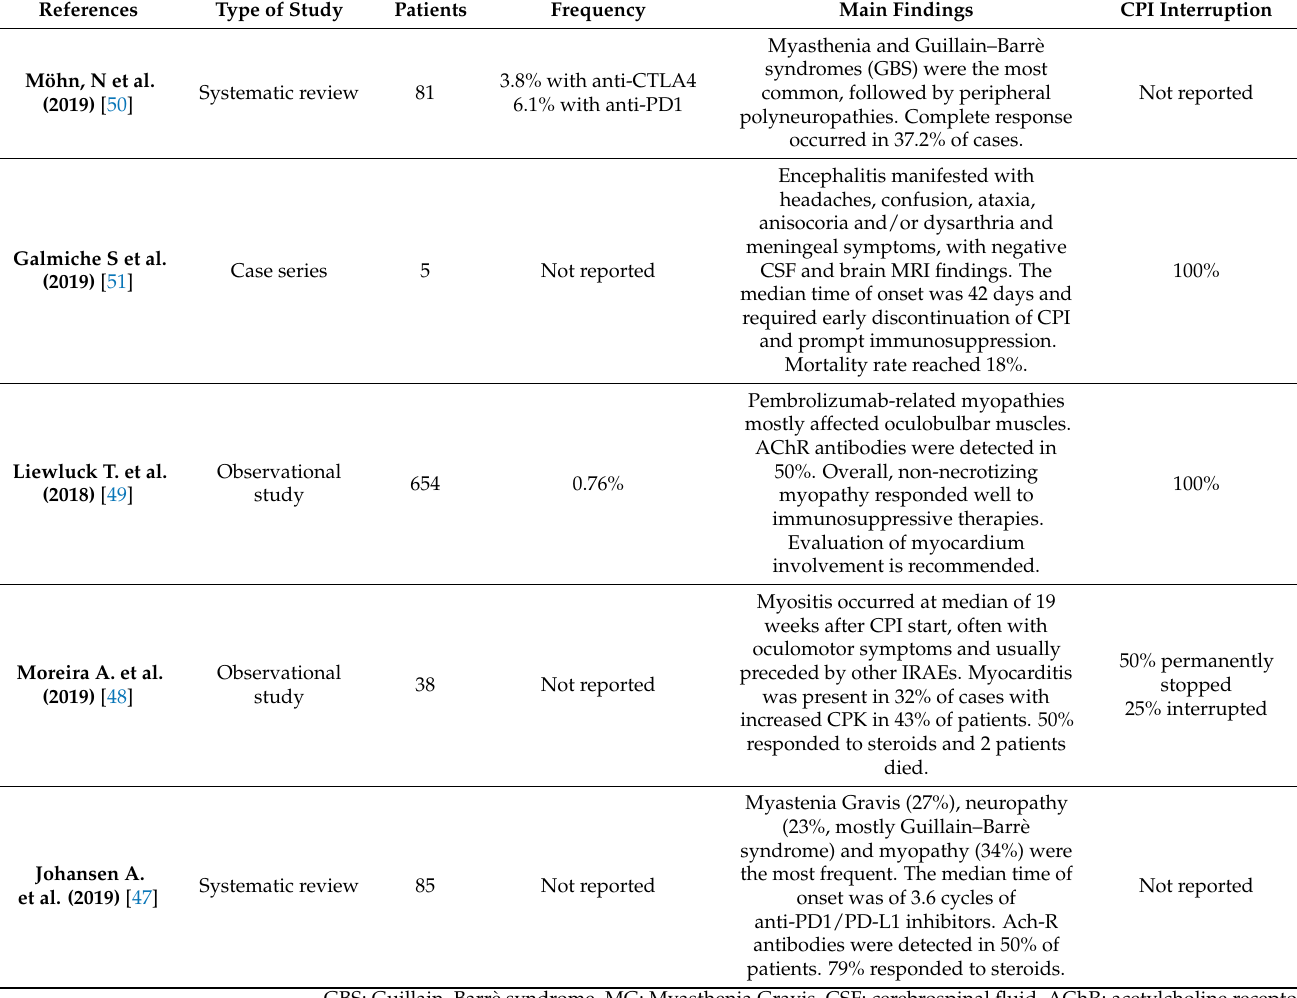
Table 5. Neuromuscular toxicities after checkpoint inhibitors